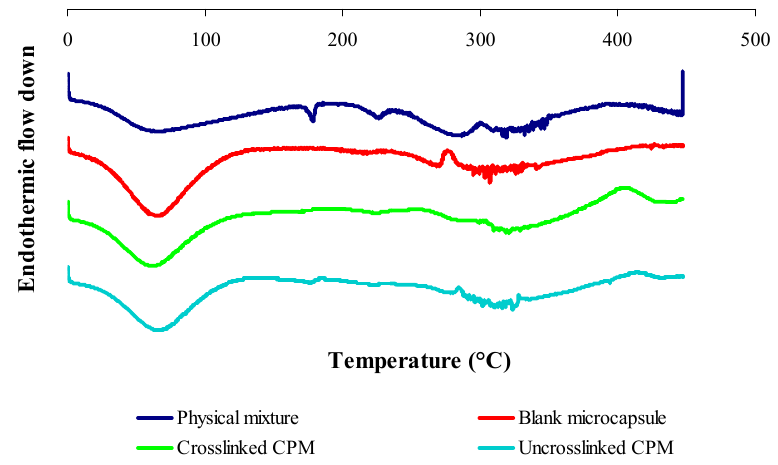
Figure 5. DSC thermograms of physical mixtures of raw materials, blank microcapsules, cross-linked and non-cross-linked curcuminoids microcapsules (CPM) .